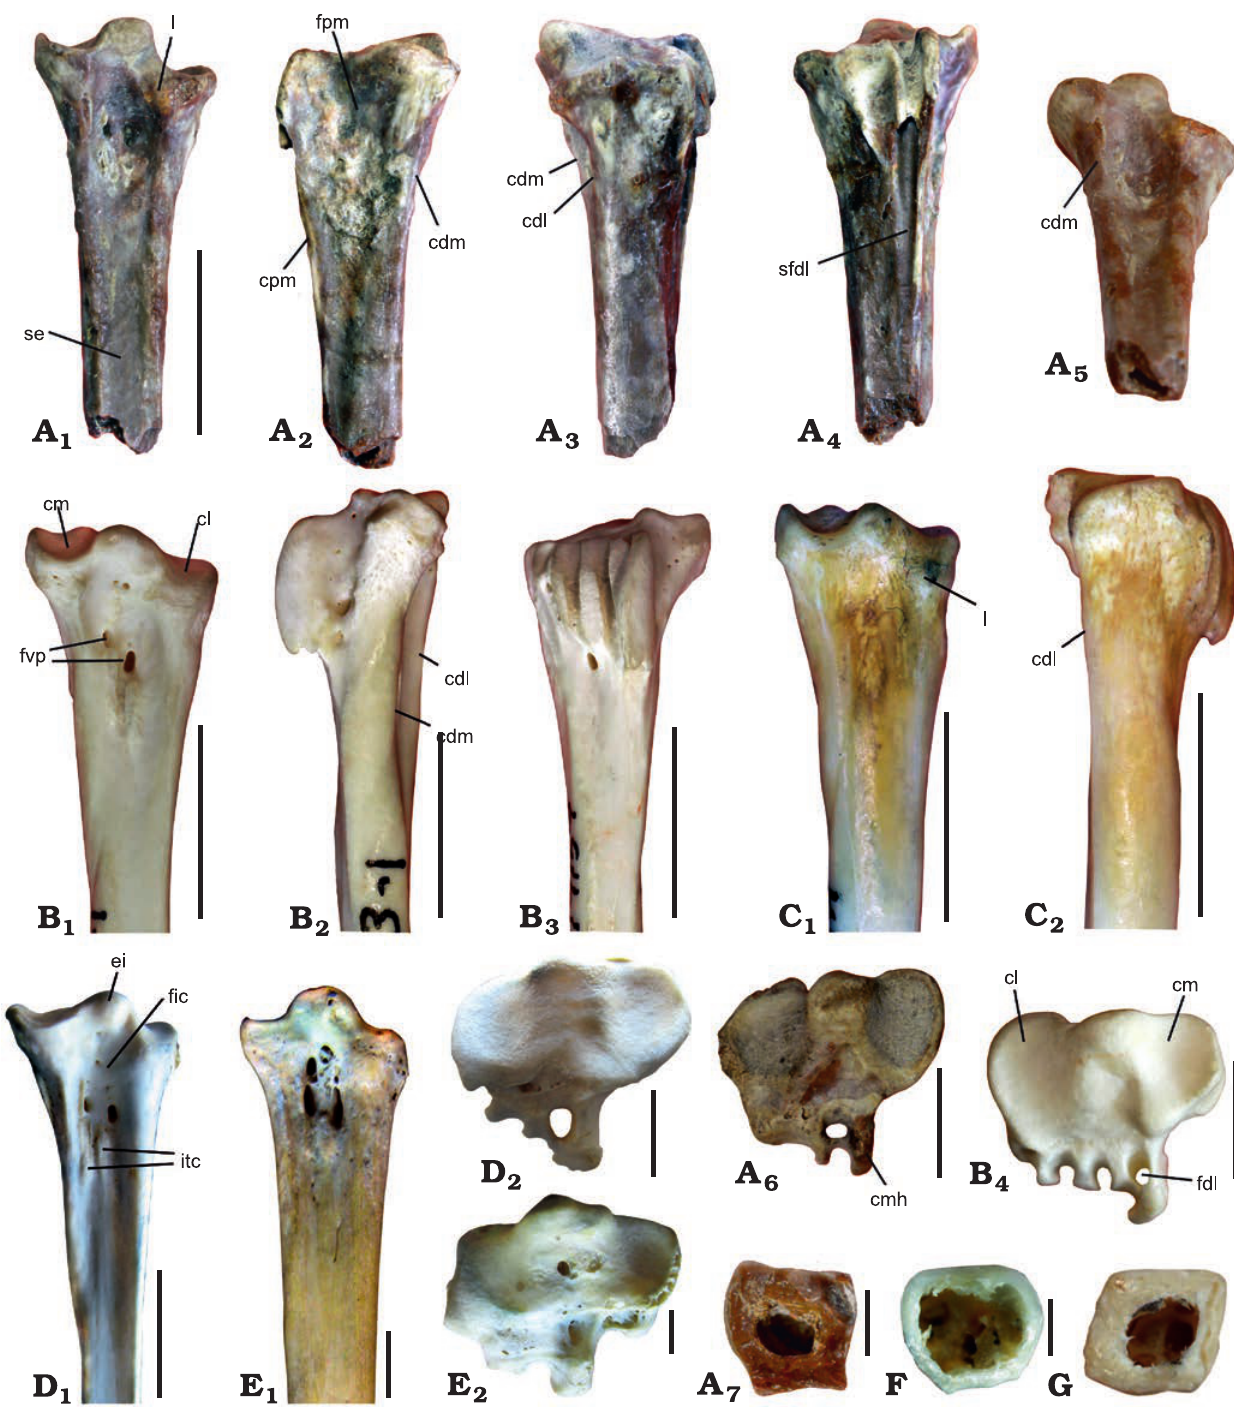
Fig. 2. Tarsometatarsi of anseriform bird Cousteauvia kustovia gen. et sp. nov. and selected modern Anseriformes. A . Cousteauvia kustovia gen. et sp. nov., holotype PIN 2612/4, latest Eocene of Kusto-Kyzylkain, Eastern Kazakhstan, in dorsal (A 1 ), medial (A 2 ), lateral (A 3 ), plantar (A 4 ), angled disto- dorsal (A 5 ), and proximal (A 6 ) views, and distal view on the cross-section (A 7 ). B . Melanitta perspicillata Linnaeus, 1758 (Anatidae), PIN 41-9-1, Recent, in dorsal (B 1 ), medial (B 2 ), plantar (B 3 ), and proximal (B 4 ) views. C . Anas undulata Dubois, 1839 (Anatidae), PIN 40-32-2, Recent, in dorsal (C 1 ) and lateral (C 2 ) views. D . Anseranas semipalmata (Latham, 1798) (Anseranatidae), USNM 621019, Recent, in dorsal (D 1 ) and proximal (D 2 ) views. E . Anhima cornuta (Linnaeus, 1766) (Anhimidae), USNM 345208, Recent, in dorsal (E 1 ) and proximal (E 2 ) views. F . Anas platyrhynchos Linnaeus, 1758 (Anatidae), PIN 40-30-3, Recent, in distal view on the cross-section. G . Clangula hyemalis (Linnaeus, 1758) (Anatidae), PIN 41-7-8, Recent, in distal view on the cross-section. Abbreviations: cdl, dorsolateral crest of the shaft; cdm, dorsomedial crest of the shaft; cl, cotyla lateralis; cm, cotyla medialis; cmh, crista medialis hypotarsi; cpm, crista plan- taris medialis; ei, eminentia intercotylaris; fdl, canal for tendon of m. flexor digitorum longus; fic, fossa infracotylaris; fpm, fossa parahypotarsalis medialis; fvp, foramina vascularia proximalia; itc, impressio m. tibialis cranialis; se, sulcus extensorius; sfdl, sulcus for tendon of m. flexor digitorum longus; l, lip-like distal extension of the cotyla lateralis. Scale bars: A 1 –A 5 , B 1 –B 3 , C, D 1 , 10 mm; A 6 , B 4 , D 2 , E 2 , 5 mm; A 7 , F, G, 2